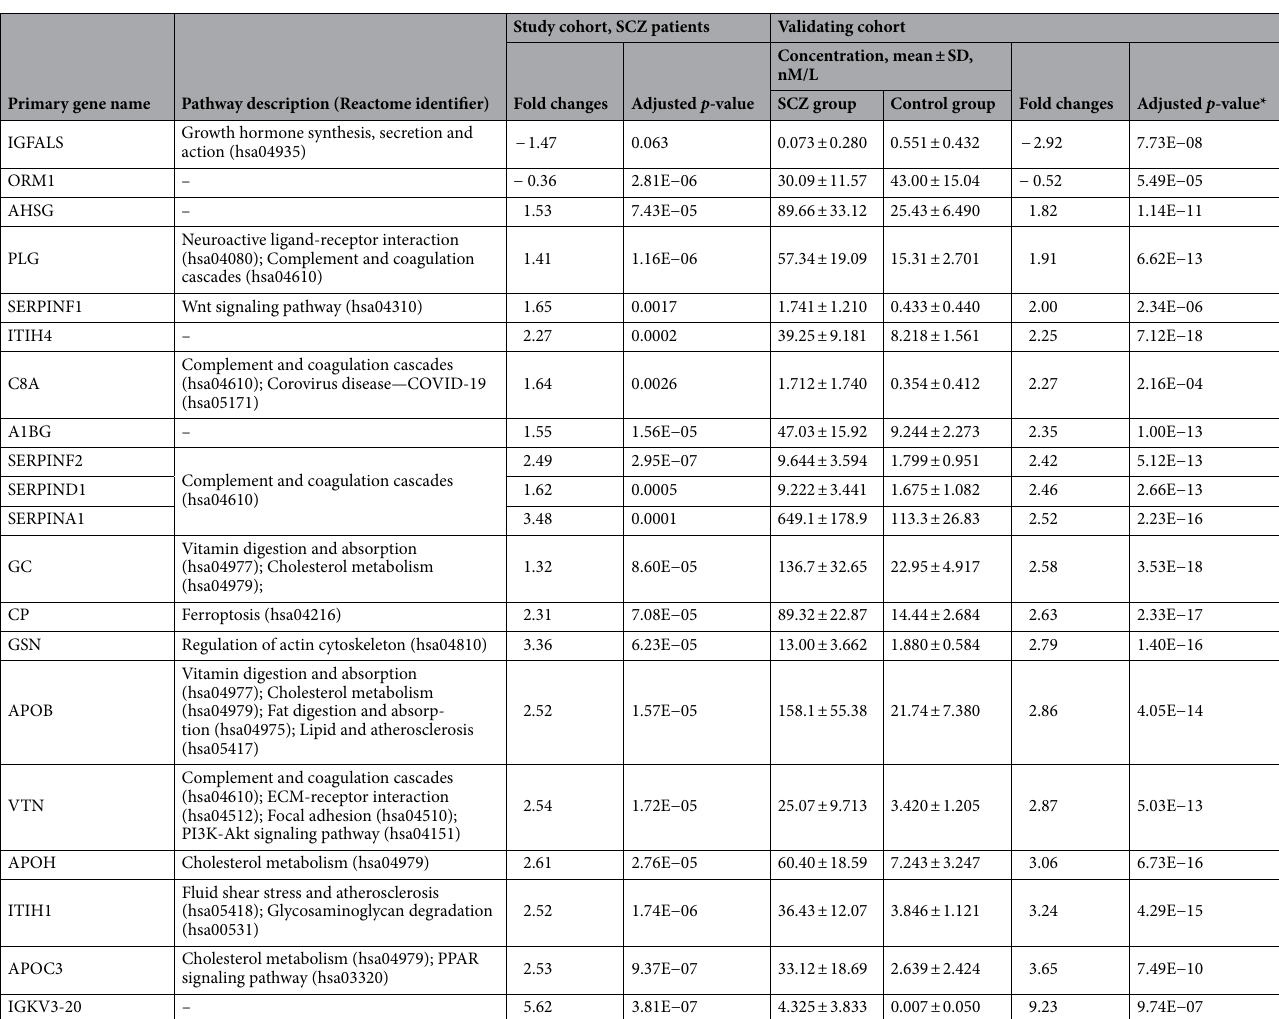
Table 1. Most significantly altered proteins measured in the study cohort (estimated as fold-changes; 1 < log2FC < (− 1) in logarithmic scale, Benjamini–Hochberg adjusted p -value cut-off p < 0.01) and in